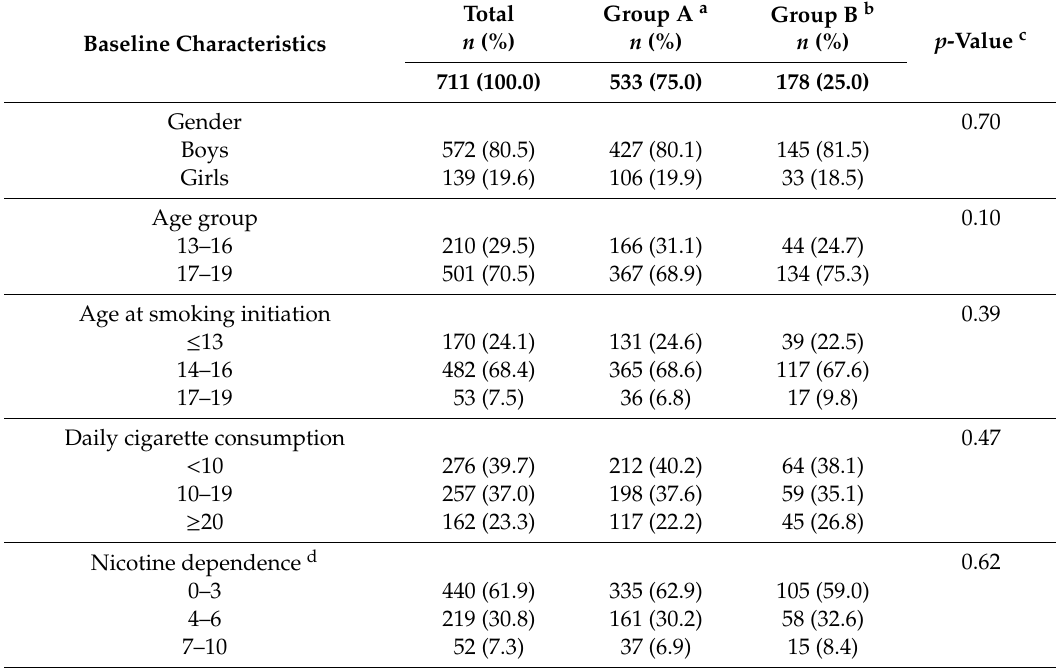
Table 1. Baseline characteristics of adolescent Quitline users by cessation